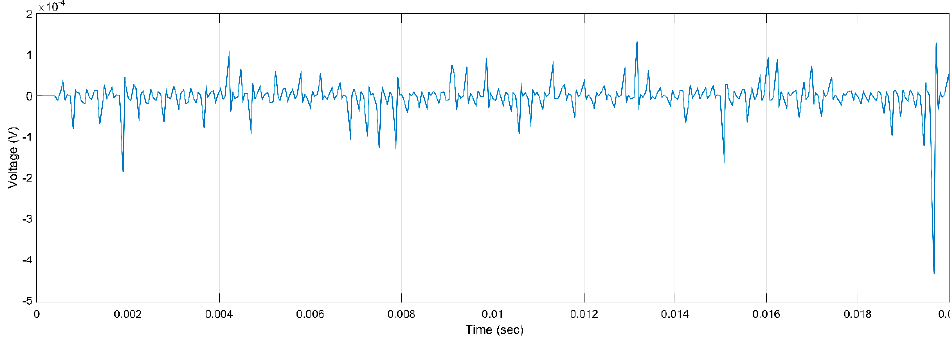
Figure 11. PD Activity for Combination, 15 kV, 2 h, r.